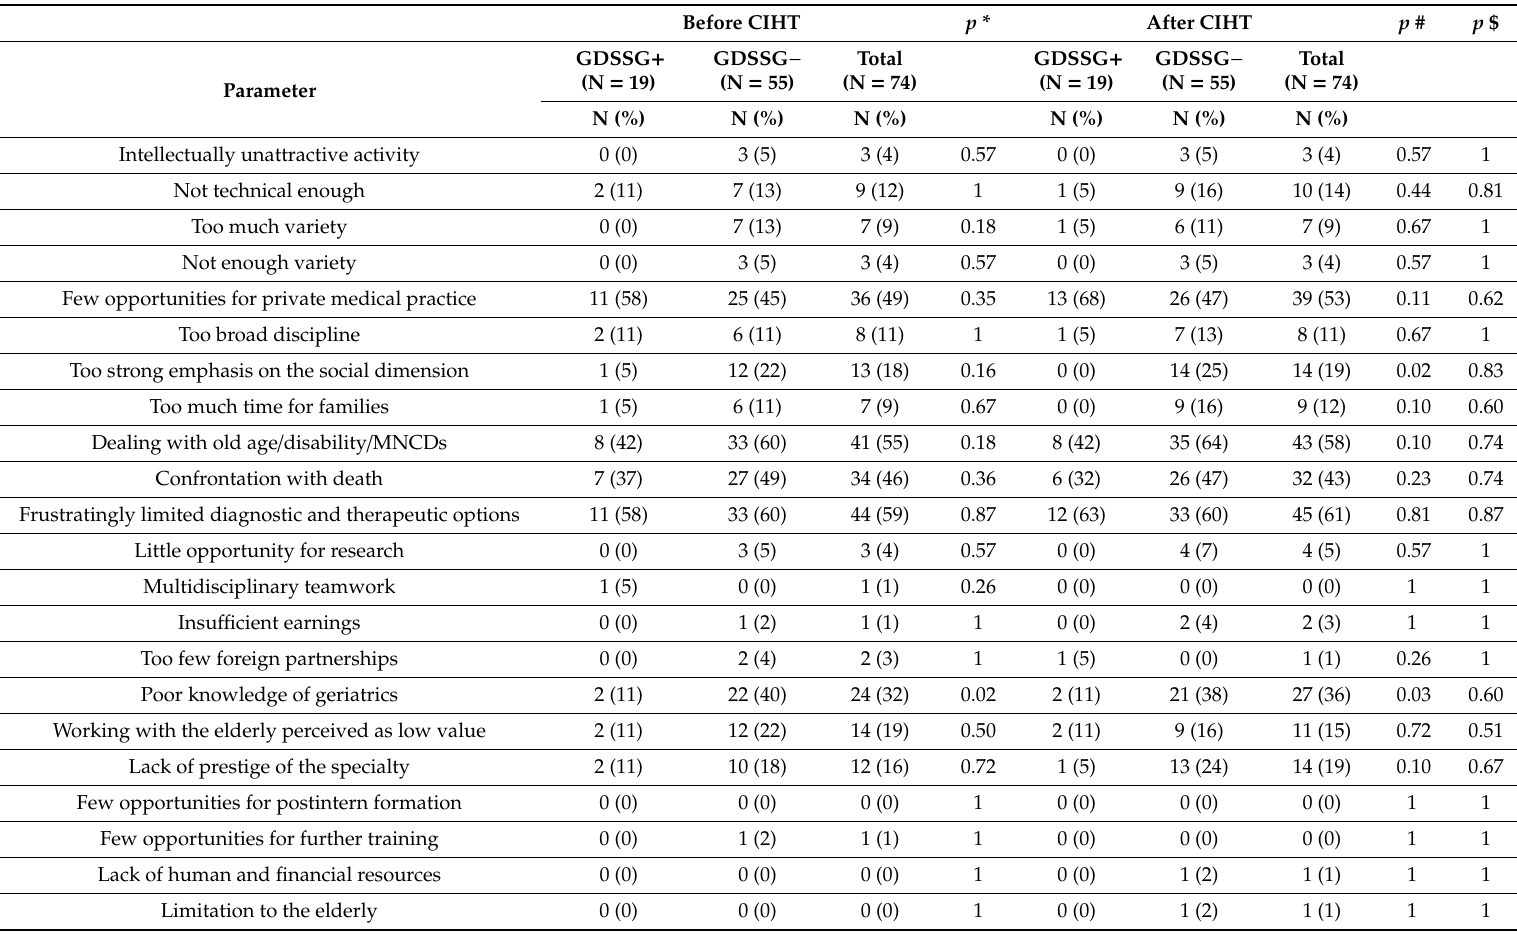
Table 4. Negative points of geriatrics according to students before and after CIHT for the GDSSG + or GDSSG −